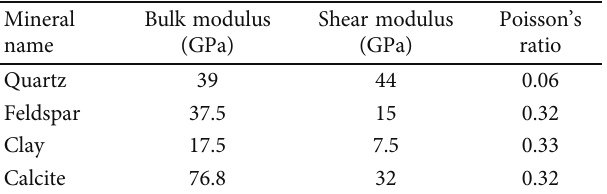
Figure 10: Thin-section features corresponding to elastic parameters and physical properties of tested samples under di ff erent diagenetic conditions. (a) Sample no. 18, well Ma19 ( V p = 3 : 6km/s , ϕ = 14 : 3 % ). (b) Sample no. 5, well Ma18 ( V p = 4 : 1km/s , ϕ = 14 : 7 % ). (c) Sample Table 1: Elastic parameters of